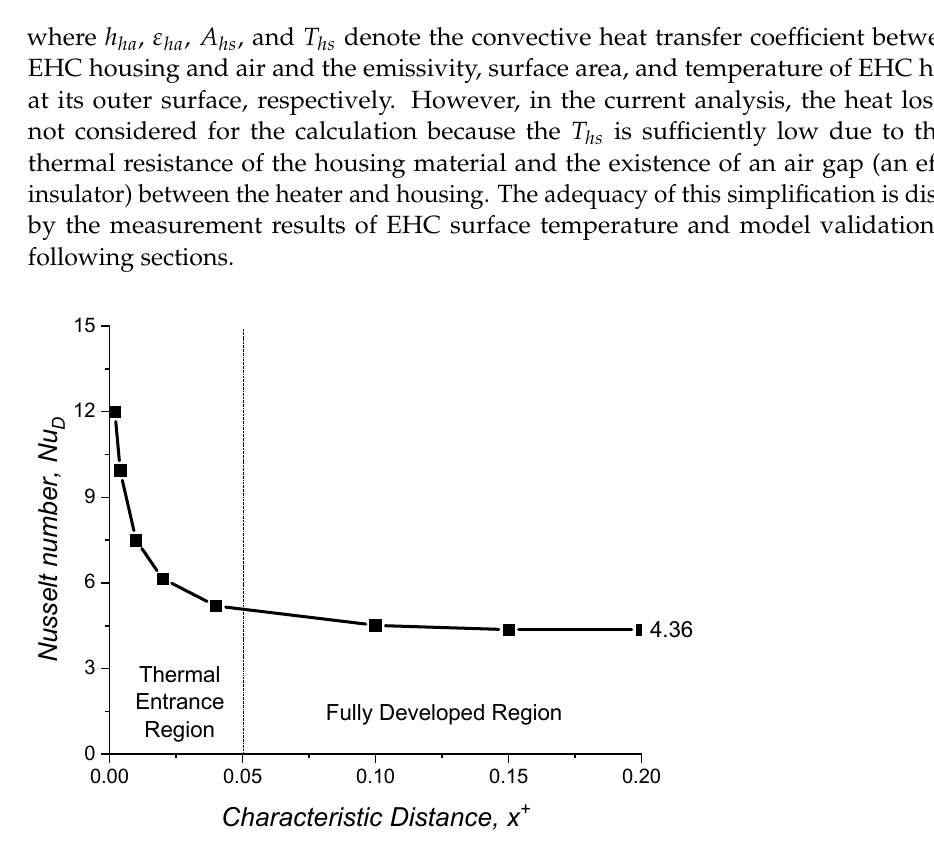
Figure 4. Nusselt number of laminar flows inside circular tubes in the thermal entrance region [30].